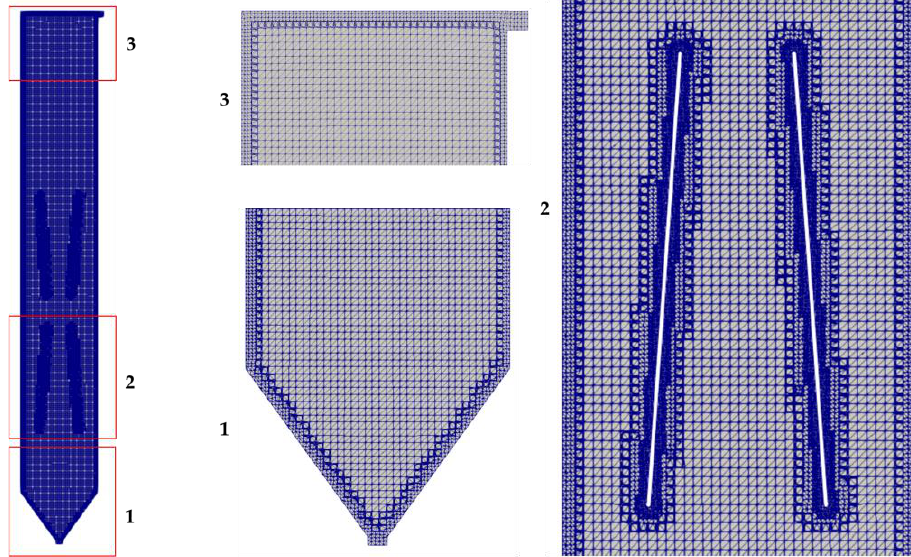
Figure 5. Visualization of the mesh of geometry 8. Inlet and coned transition marked with 1, bottom draft tube marked with 2 and reactor’s top and outlet marked with 3.